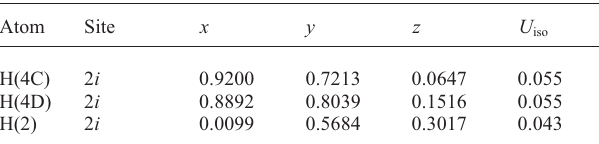
Table 2. Atomic coordinates and displacement parameters (in Å 2 ) .